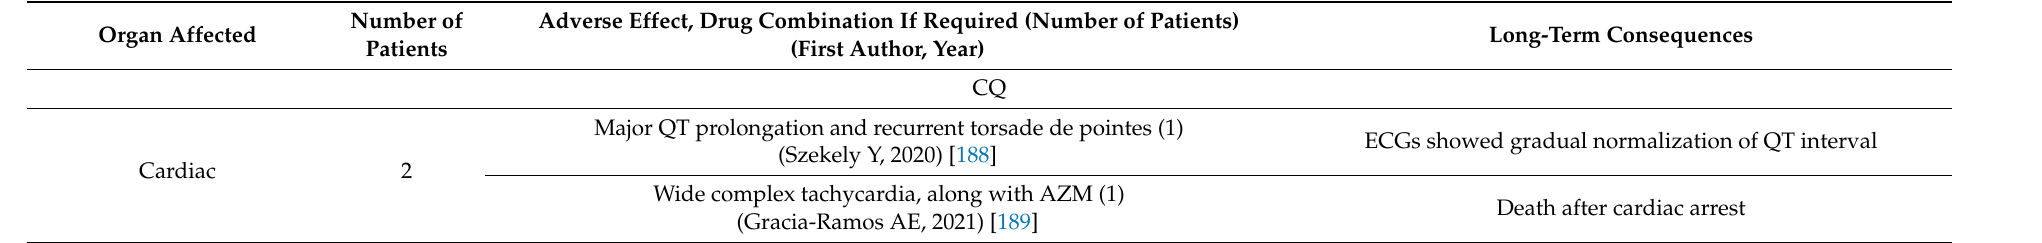
Table 6. Summary of studies included: COVID-19 case reports related to chloroquine or hydroxychloroquine adverse effects in patients with suspected or confirmed COVID-19 or who were prophylactically